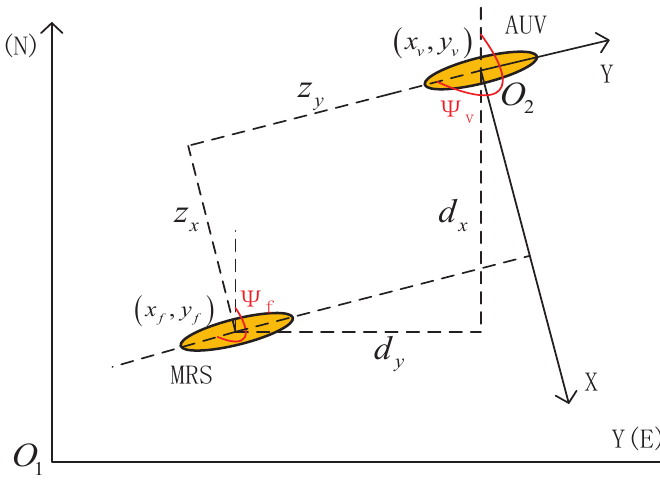
Figure 3. Coordinate frames schematic